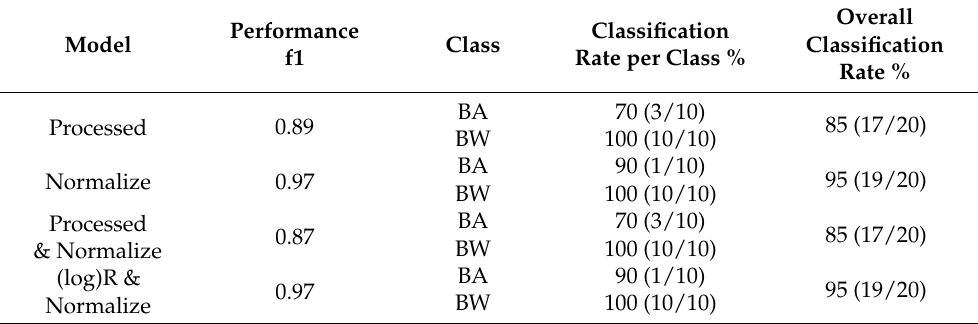
Table 3. Classification rate in prediction set with the four models for farmed/wild sea bass. Classification Performance Class Model Rate per Class f1